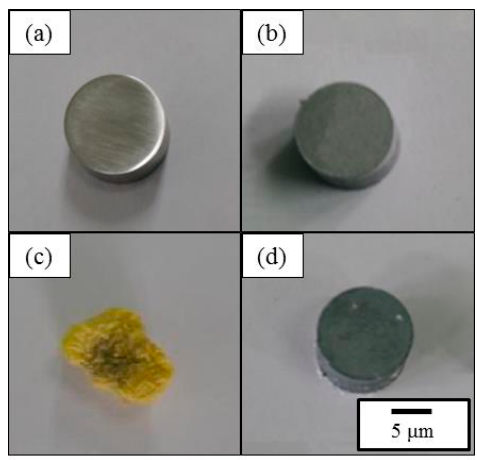
Figure 1. Surface image of ( a ) the as-received TZM alloy; ( b ) after coating the TZM alloy at 1100 ◦ C for 6 h; ( c ) oxidized TZM alloy at 1300 ◦ C for 50 h; and ( d ) MoSi 2 -coated TZM alloy oxidized at 1350 ◦ C for 50